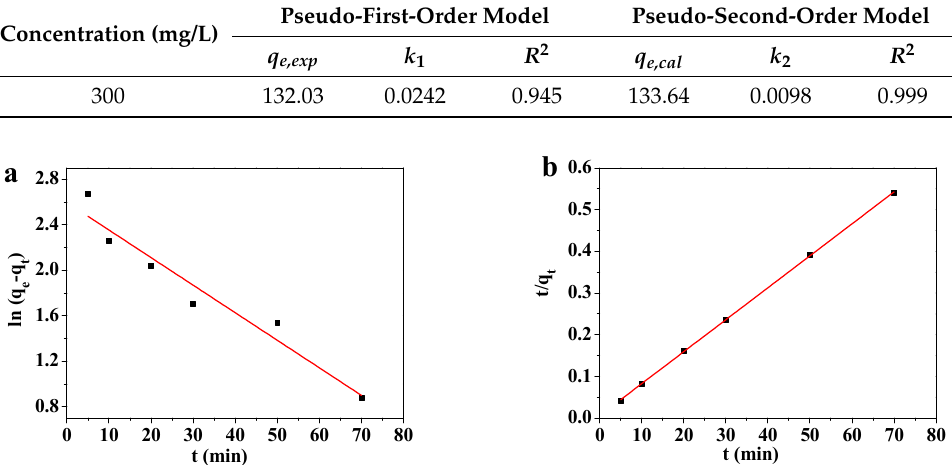
Figure 11. ( a ) Pseudo-first-order and ( b ) pseudo-second-order kinetics modeling of the adsorption of Pb(II) by MOF-5–CMC beads.